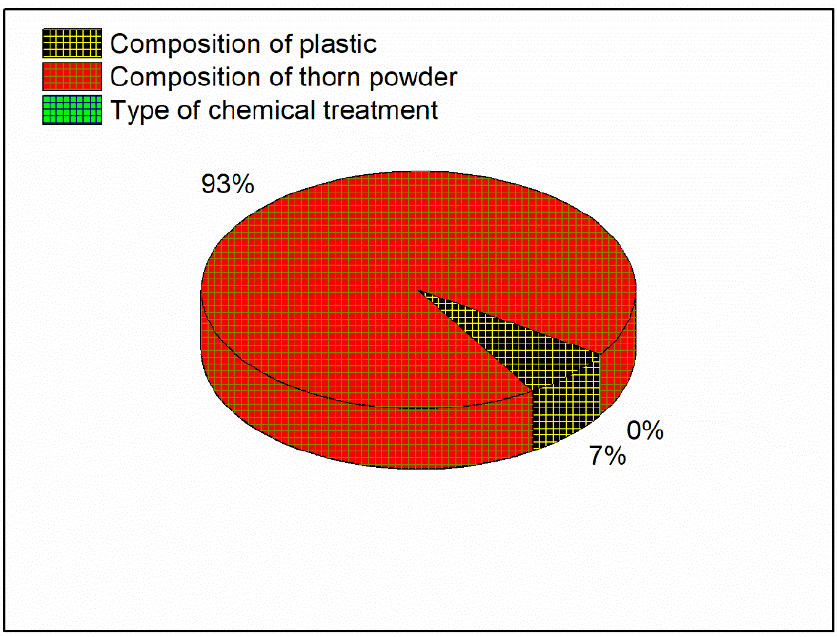
Figure 17. Contribution plot for Minimum wear rate.